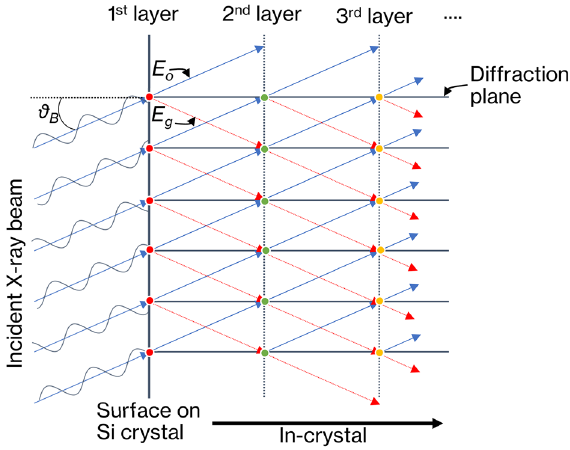
Figure 7. X-ray beam propagation in the